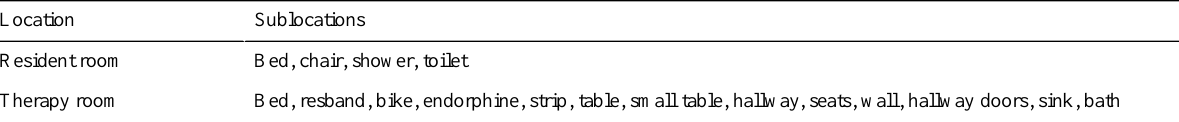
Table 3. Locations of interest. For sensor-based feature assessment throughout the paper, shower, toilet, and sink are considered as bathroom; walls 1, 2, and 3 as wall; beds 1 to 4 inside the therapy room and beds 1 and 2 inside the resident room as